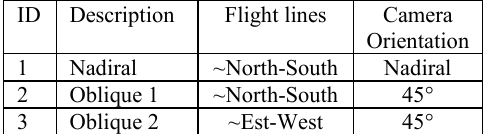
Table 1. UAVs flights' main characteristics for each of the 7 areas documented.